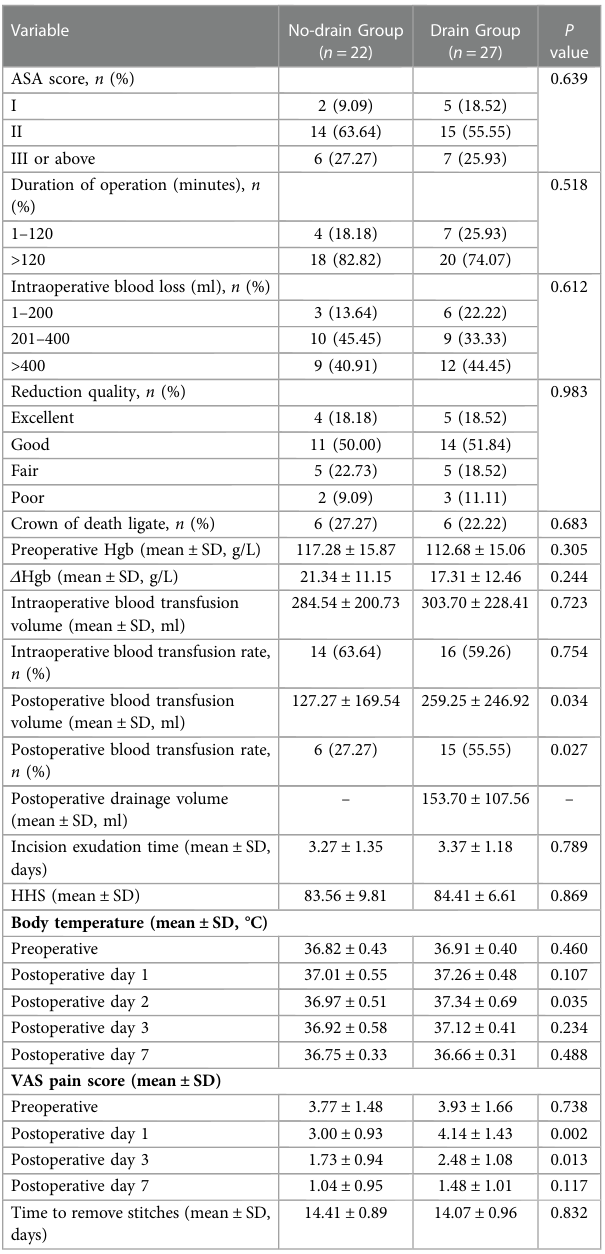
TABLE 3 Detailed presentation of postoperative incision-related complications between the two groups.